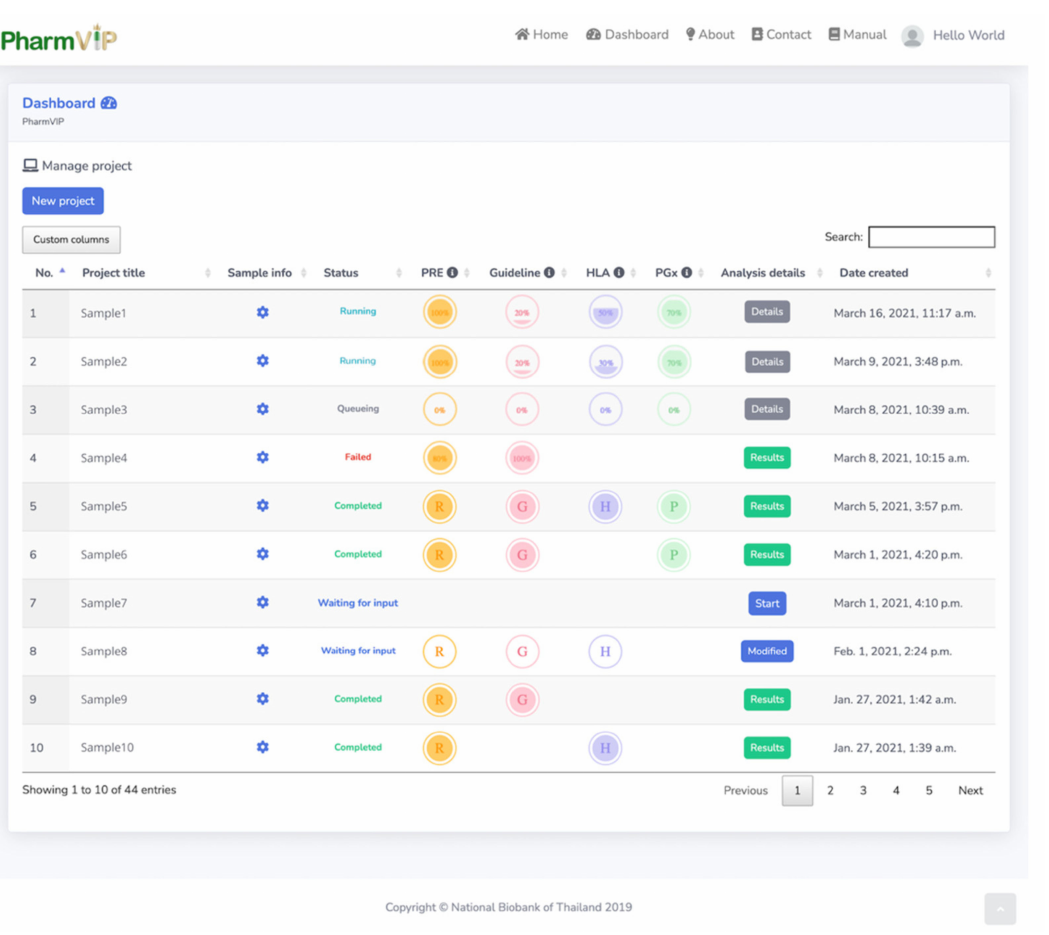
Figure 1. Overview of PharmVIP analysis modules. Software architecture of PharmVIP showing types of input files (VCF and BAM) and output report details from the three analytic modules, namely Guideline, HLA and Pharmacogenes.